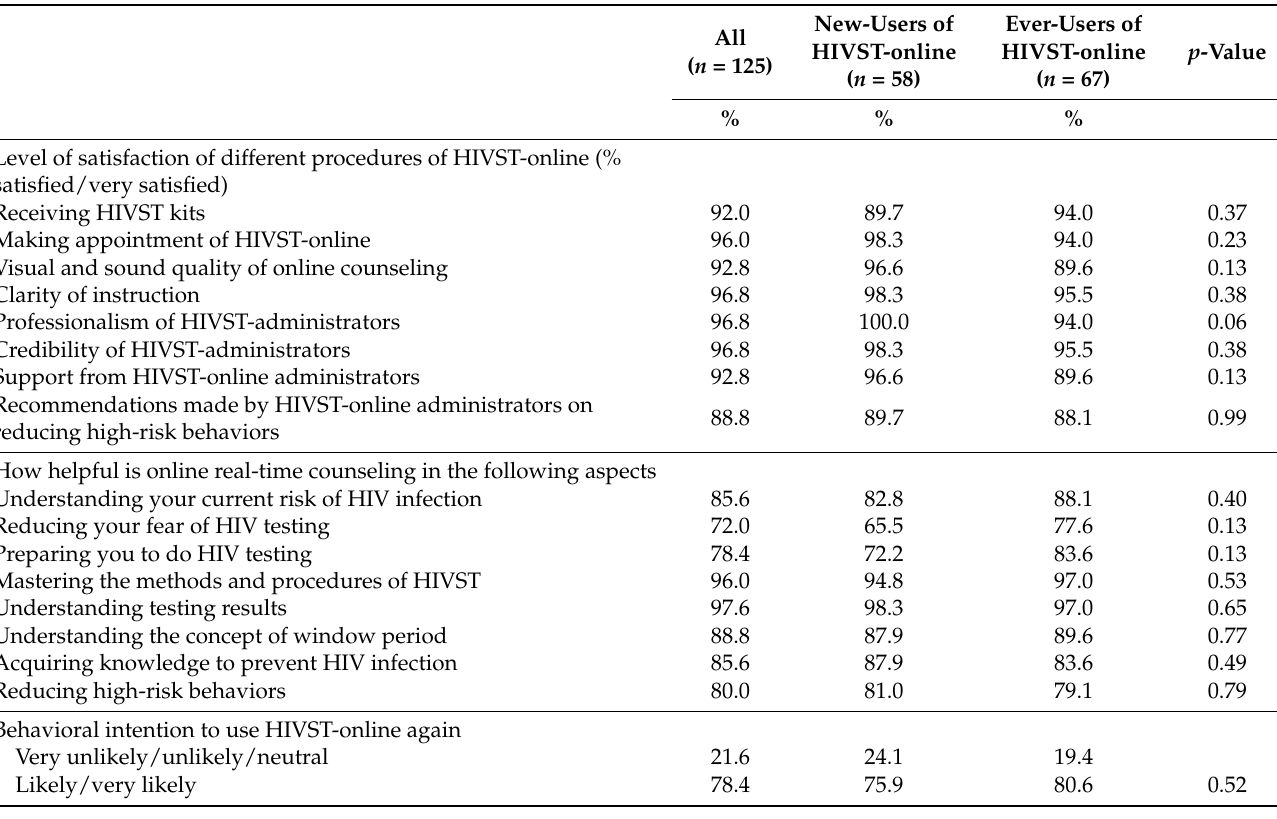
Table 5. Process evaluation of HIVST-online users (among those being followed up at month 6, n =